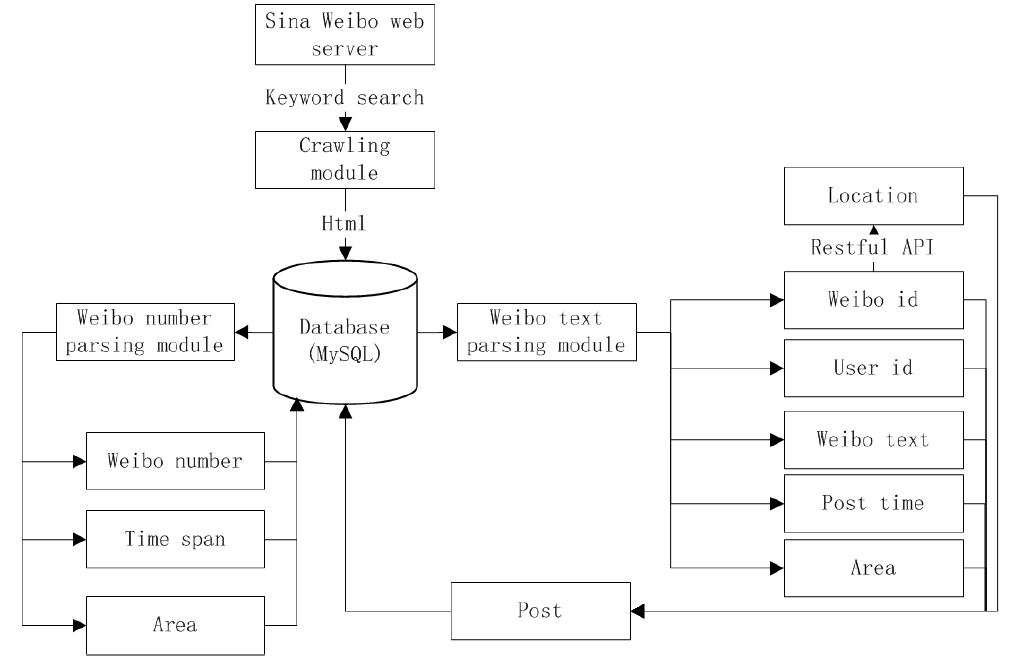
Figure 1. Data collection process.